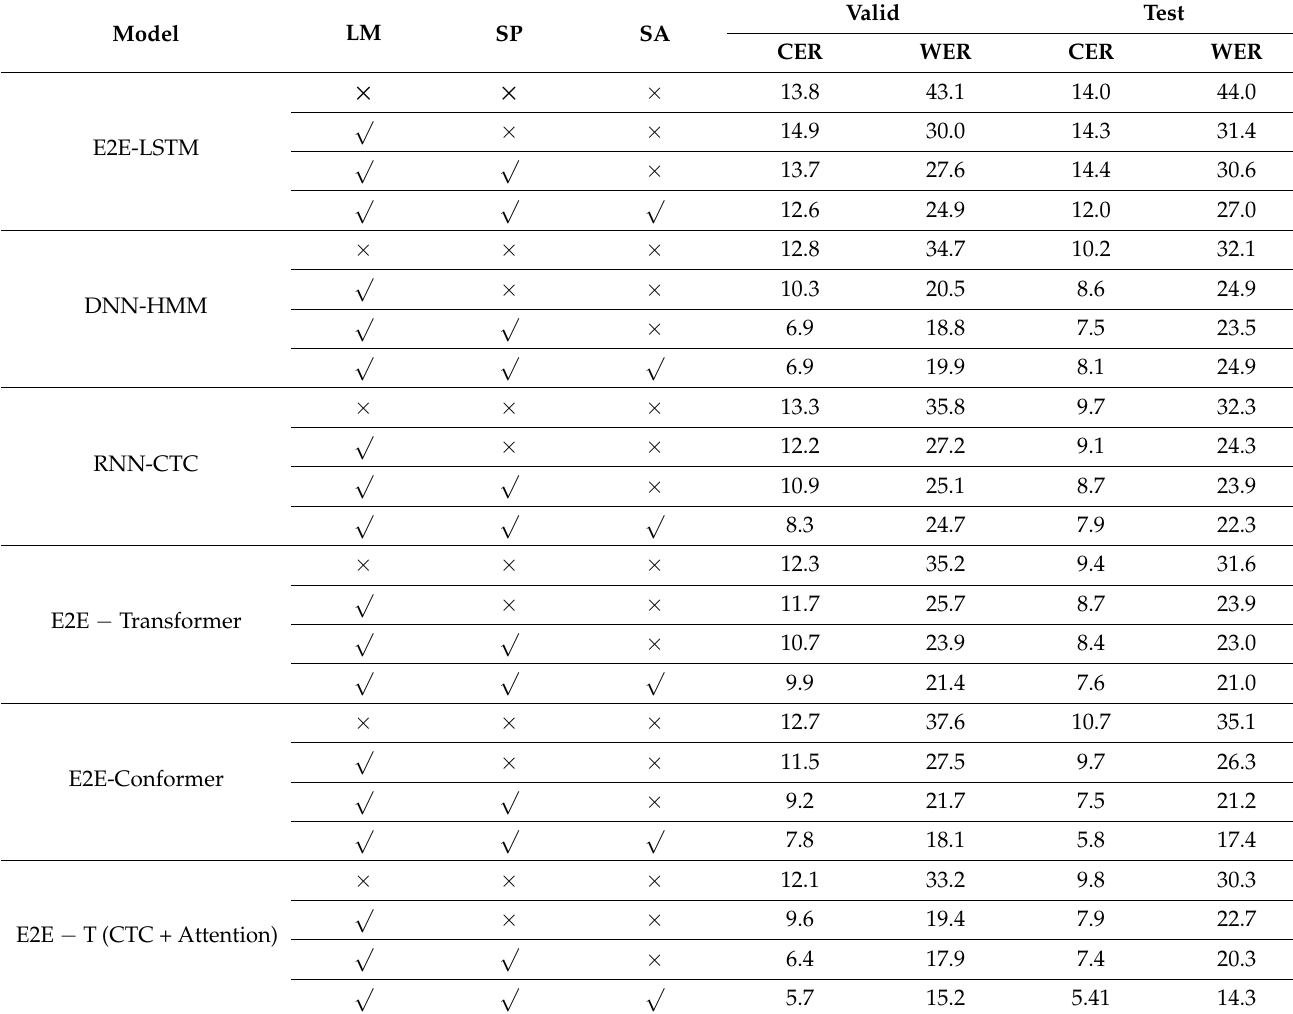
Table 8. The CER (%) and WER (%) results of different E2E ASR models were trained using the Uzbek language speech corpus. The impact of language model (LM), speed perturbation (SP), and spectral augmentation (SA) are also